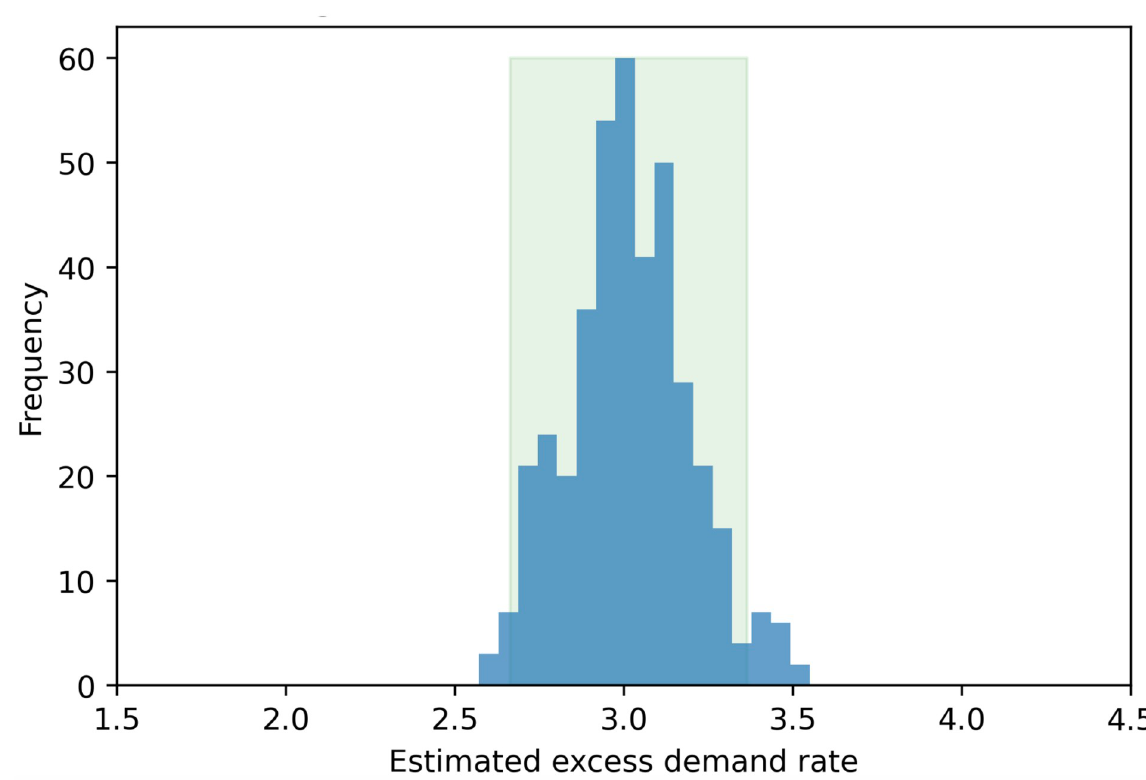
Fig 5. Histogram of estimated excess demand